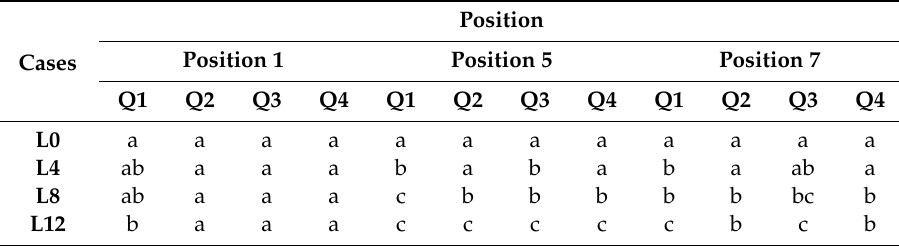
Table 3. Significance analysis of Reynold’s stress contribution values.